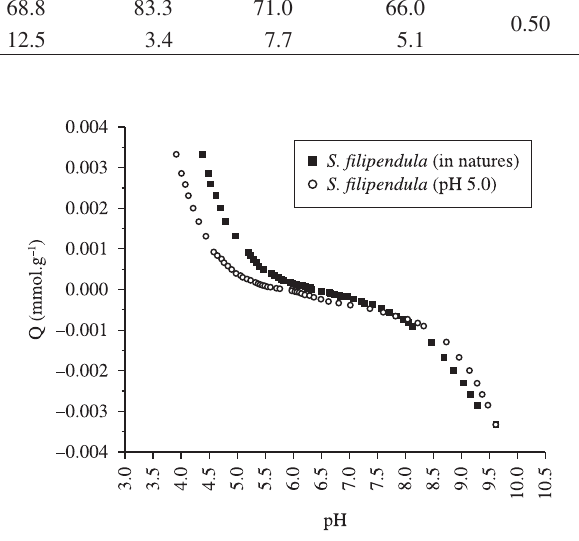
Figure 1. Total surface charge of in nature and acidified (pH 5.0) Sargassum filipendula algae as function of pH.